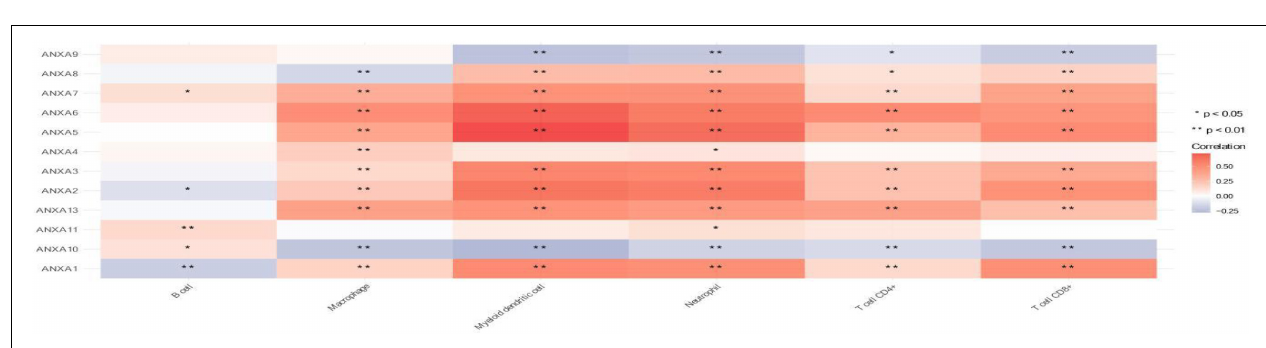
FIGURE 8 | Function enrichment of ANXA family members in BC. (A–D) GO and KEGG pathway analysis in ANXA-B. (E–H) GO and KEGG pathway analysis in ANXA-L.